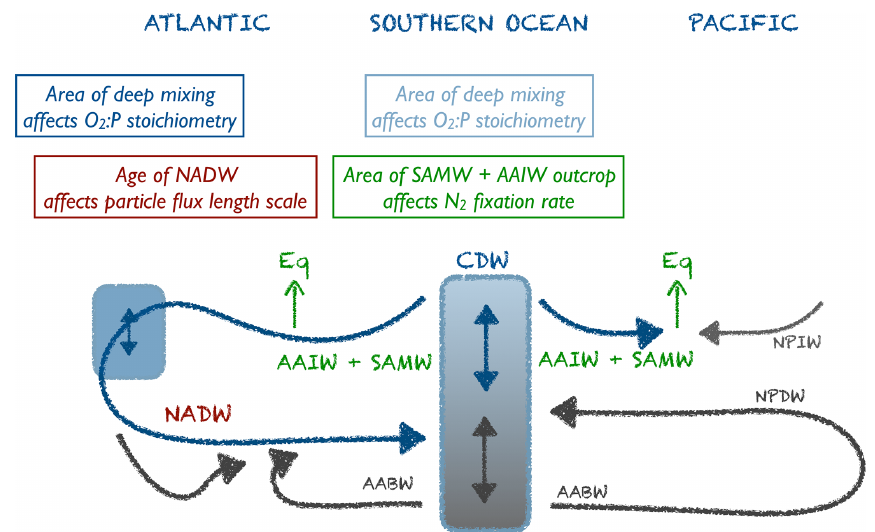
Figure 13. Cartoon depicting the simplified large-scale circulation pattern of the Atlantic and Pacific oceans and the dependence of the three biogeochemical parameters R − O , b and µ NFix on physical 2 : P